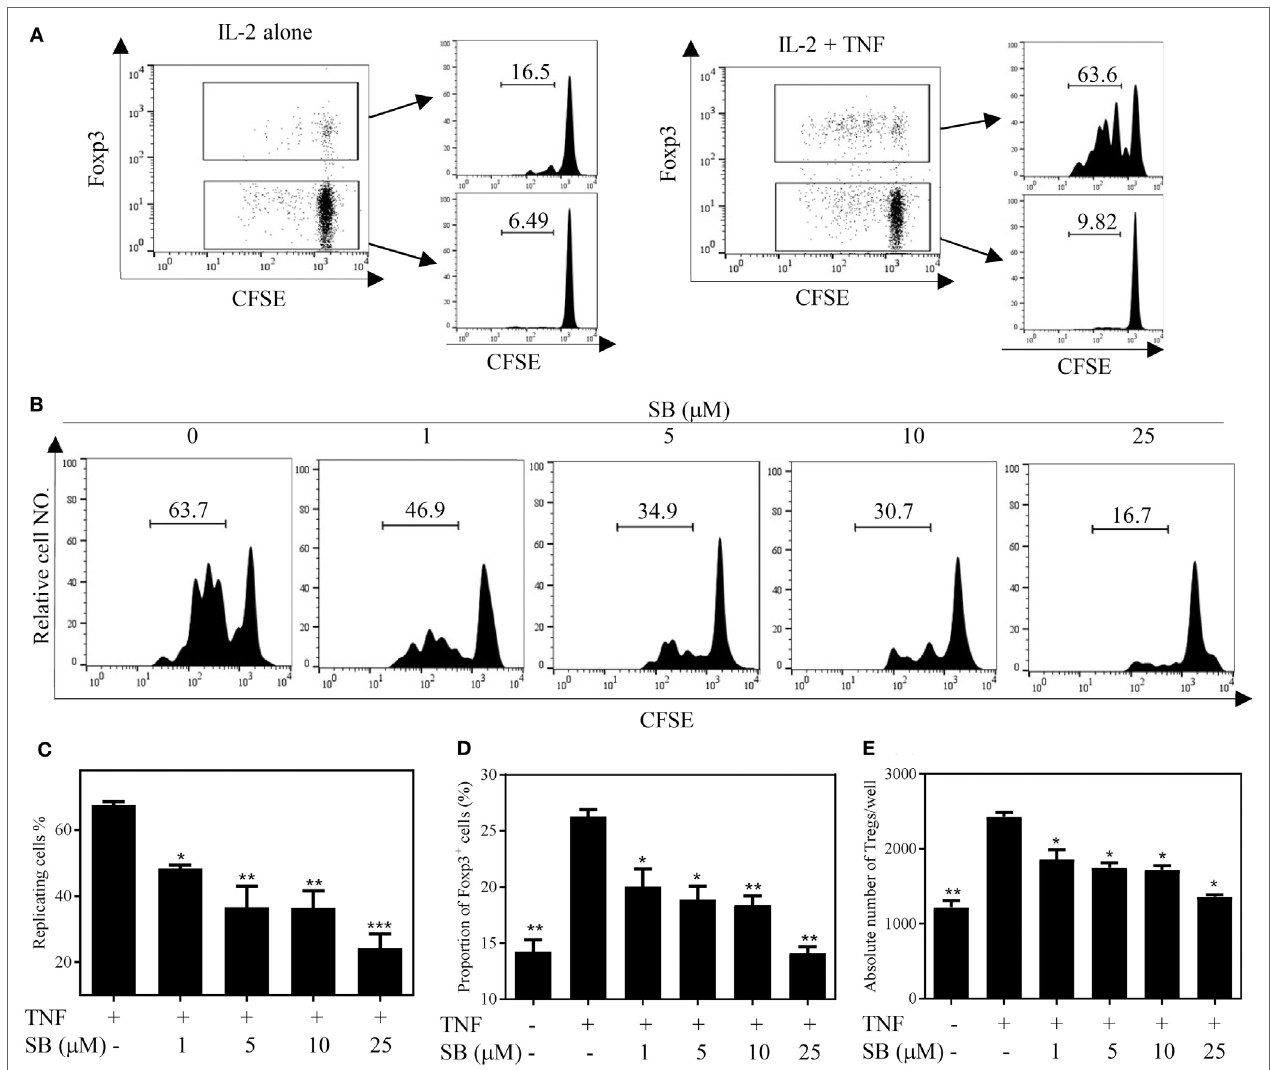
FigUre 1 | SB203580 (SB) inhibits tumor necrosis factor (TNF)-mediated expansion of regulatory T cells (Tregs) in vitro . CD4 + T cells were purified from LNs and spleen of normal C57BL/6J mice by MACS. The cells were labeled with CFSE and cultured in the presence of IL-2 (10 ng/mL), or IL-2 + TNF (10 ng/mL, each), with medium alone or with different concentrations of SB203580 (SB, 1, 5, 10, and 25 µM). After 72 h, the proliferation of Tregs and the proportion of Foxp3 + cells were analyzed by FACS, based on CFSE expression and Foxp3 expression. The absolute number of Foxp3-expressing Tregs was calculated. (a) In the presence of IL-2, TNF preferentially stimulated the proliferation of Tregs. (B,c) SB203580 blocked TNF-mediated proliferation of Tregs. Analysis was gated on Foxp3 + Tregs. (D) SB203580 decreased the proportion of Foxp3 + Tregs in the cultured CD4 + T cells. (e) SB203580 reduced the absolute number of Tregs in the cultured CD4 + T cells. (a,B) Show the typical FACS plots. The number in the histogram indicates the proportion of gated cells (%). (c,D) Show the summary of results ( N = 3, means ± SEM). By comparison with “TNF + IL-2” group, * p < 0.05, ** p < 0.01, *** p < 0.001. Data shown are representatives of at least three separate experiments with similar